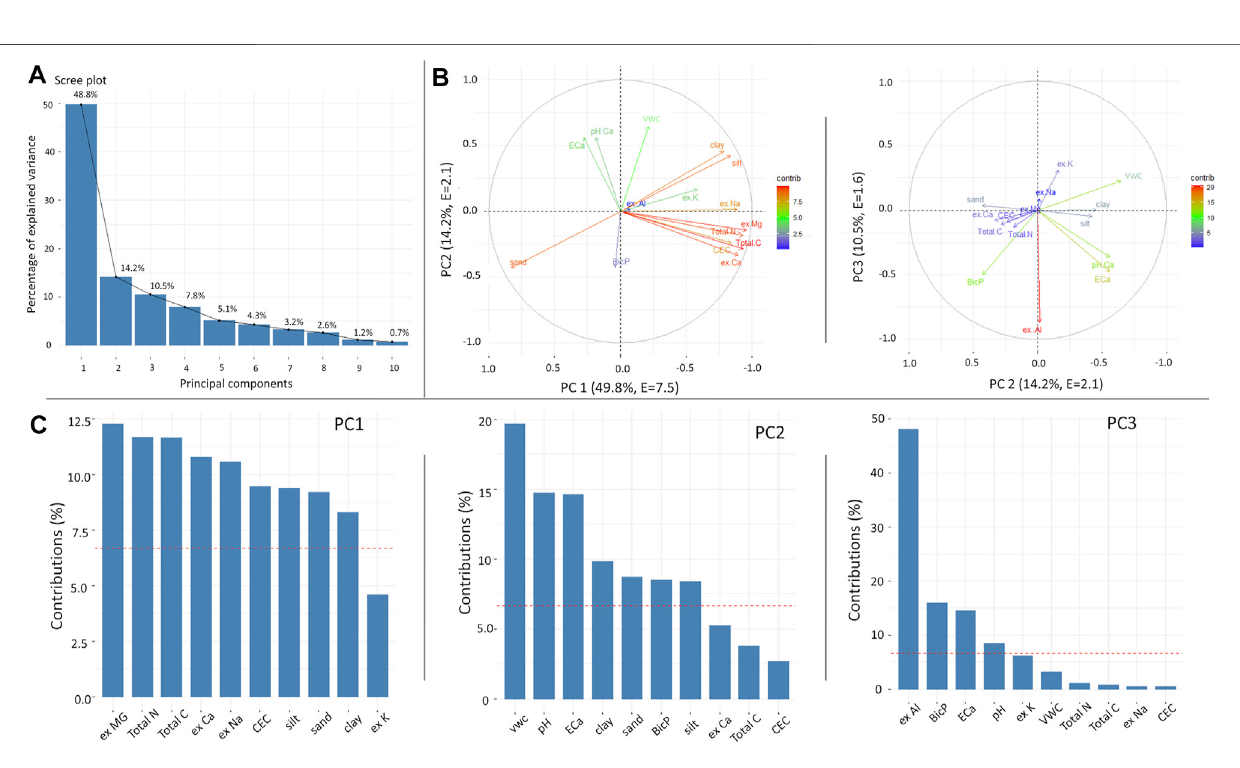
Frontiers in Environmental Science |